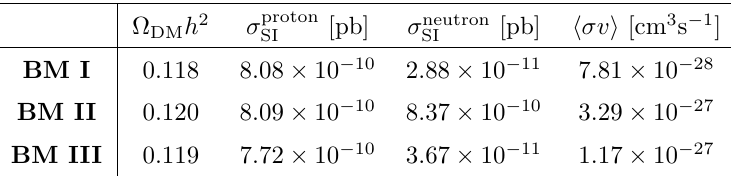
Table 5 . Predictions, for the BM I , BM II and BM III scenarios, of the observables discussed in our dark matter analysis of the previous